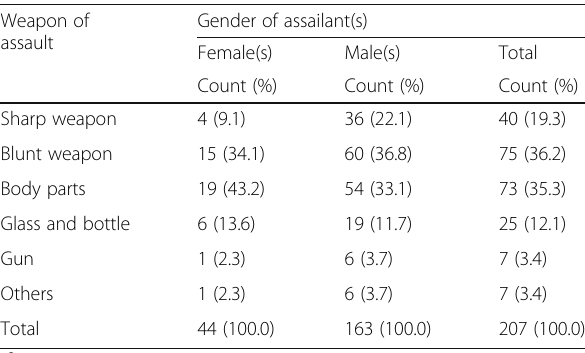
Table 4 The mechanism of assault and the assailant ’ s gender in 207 cases of non-fatal interpersonal violence Weapon of assault